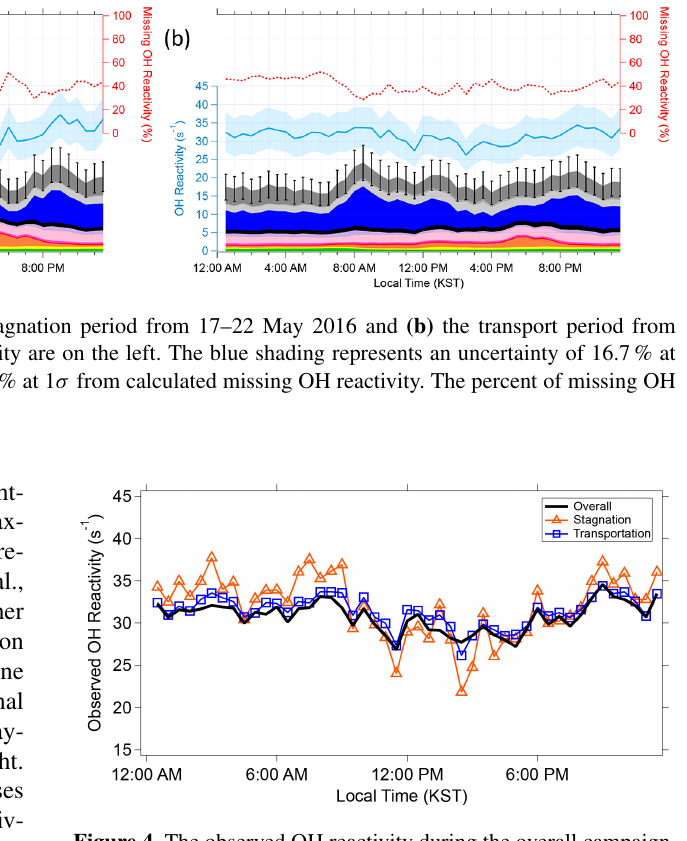
Figure 4. The observed OH reactivity during the overall campaign, stagnation period, and transport